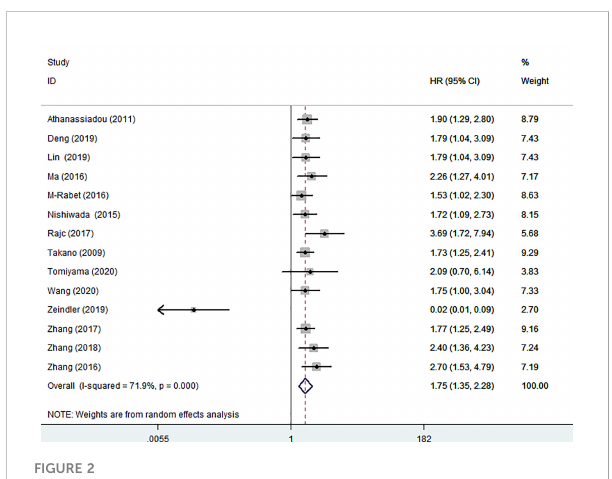
FIGURE 2 Forest plot of the relationship between high Nectin-4 expression and OS.